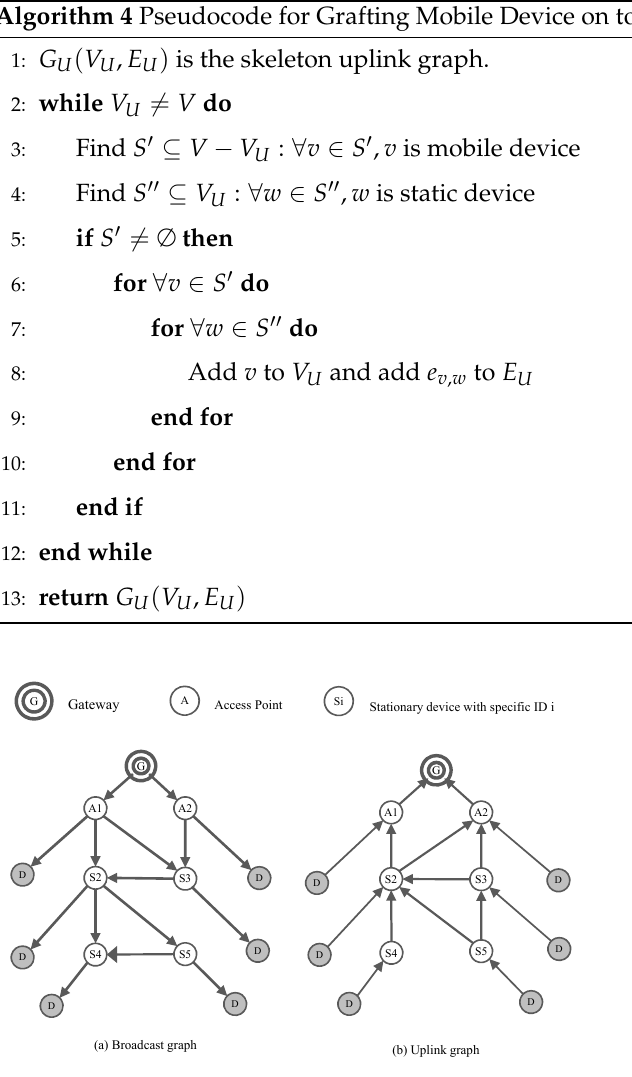
Figure 4. An example of grafting mobile device into skeleton